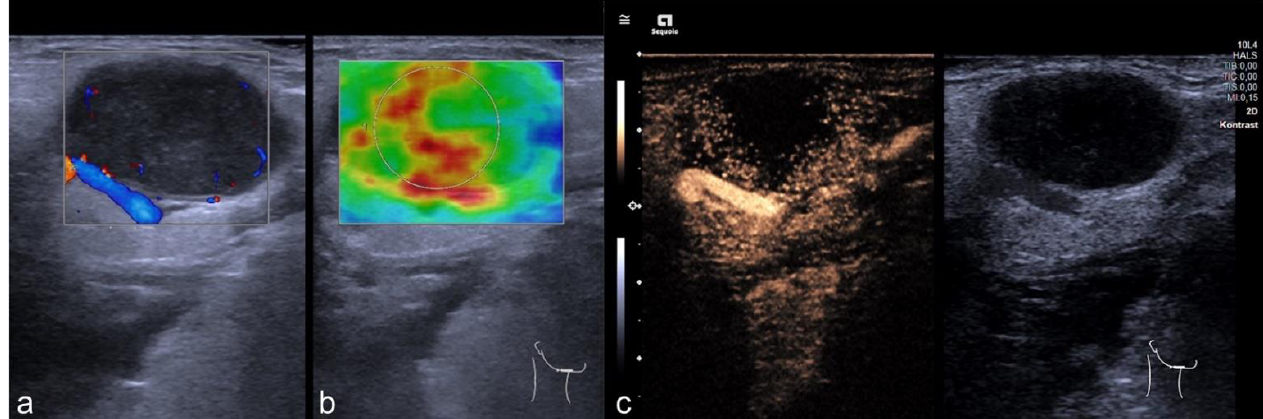
Figure 2. Representative image of mpUS. CLN suspicious for cervical manifestation of a lymphoma showed round shaped; hypoechogenic lymph nodes ( a ) with high tissue stiffness on SWE ( b ) and irregular contrast enhancement showed a large area of central necrosis ( c ). Final diagnosis was HNSCC, indicated by high stiffness on SWE.